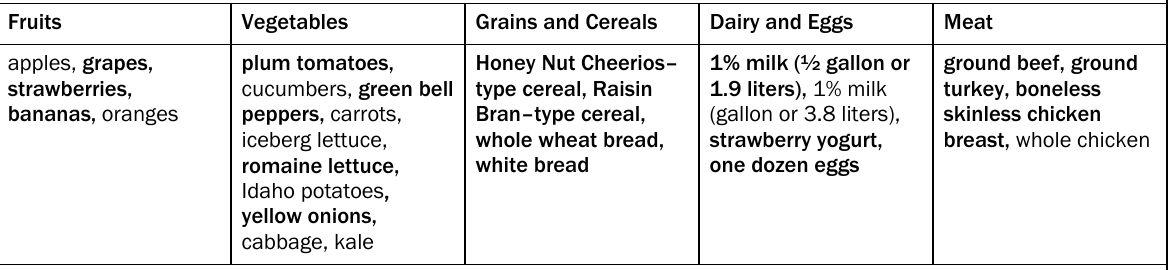
Table 1. Foods Assessed for the Conventional Food Distribution System Project Fruits Vegetables Grains and Cereals